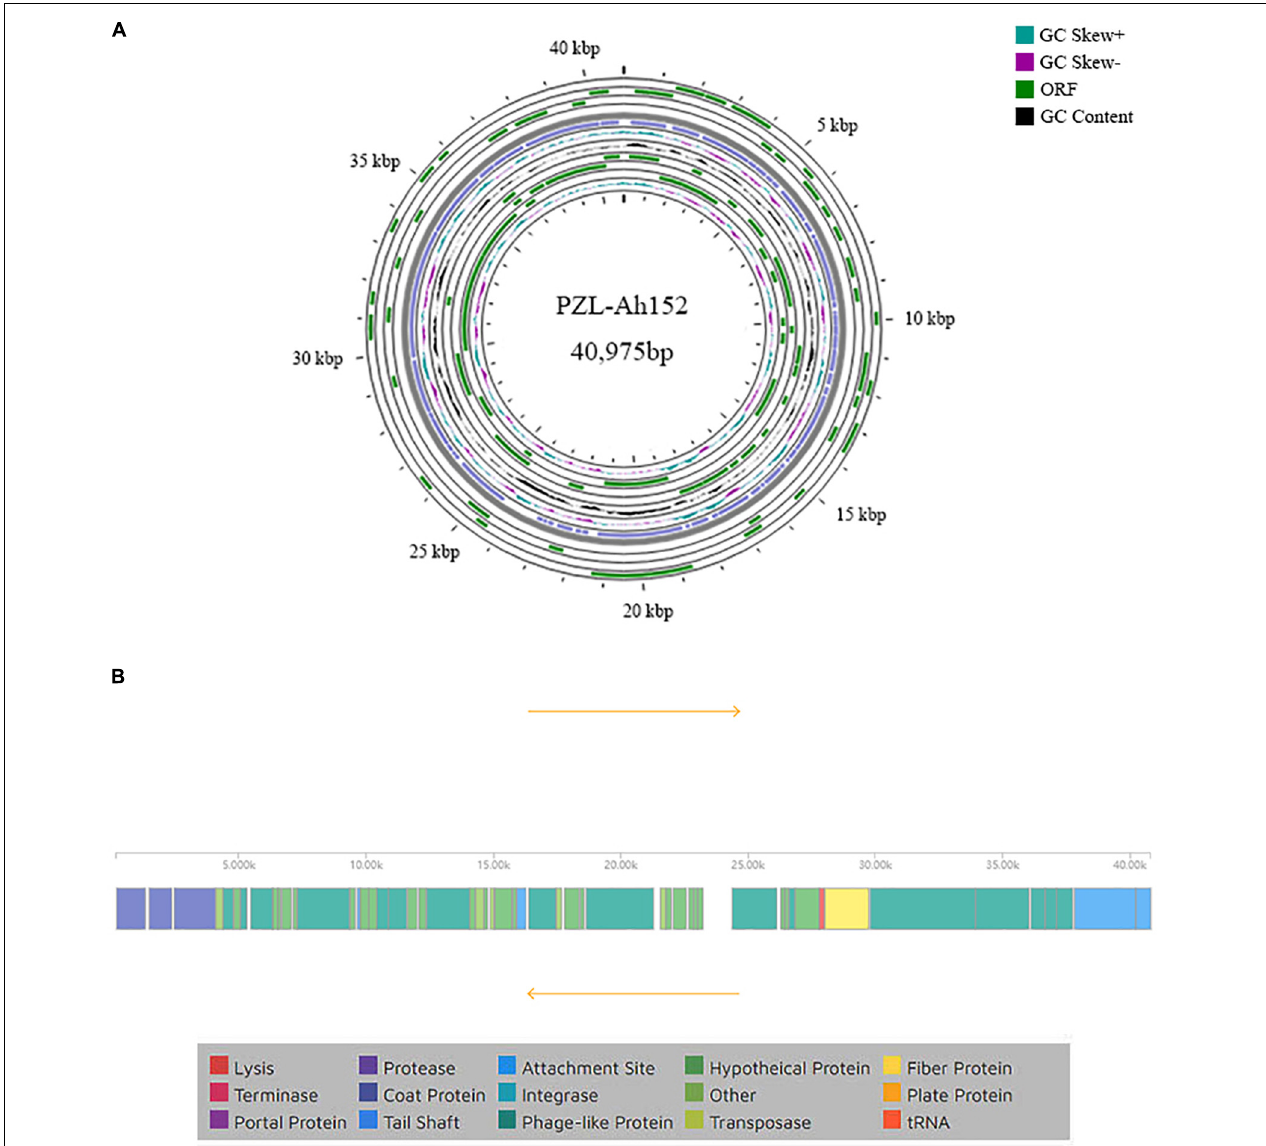
FIGURE 3 | Genome characteristics of PZL-Ah152. (A) Circular representation of PZL-Ah152 genome. (B) Genetic and physical organization of the PZL-Ah152